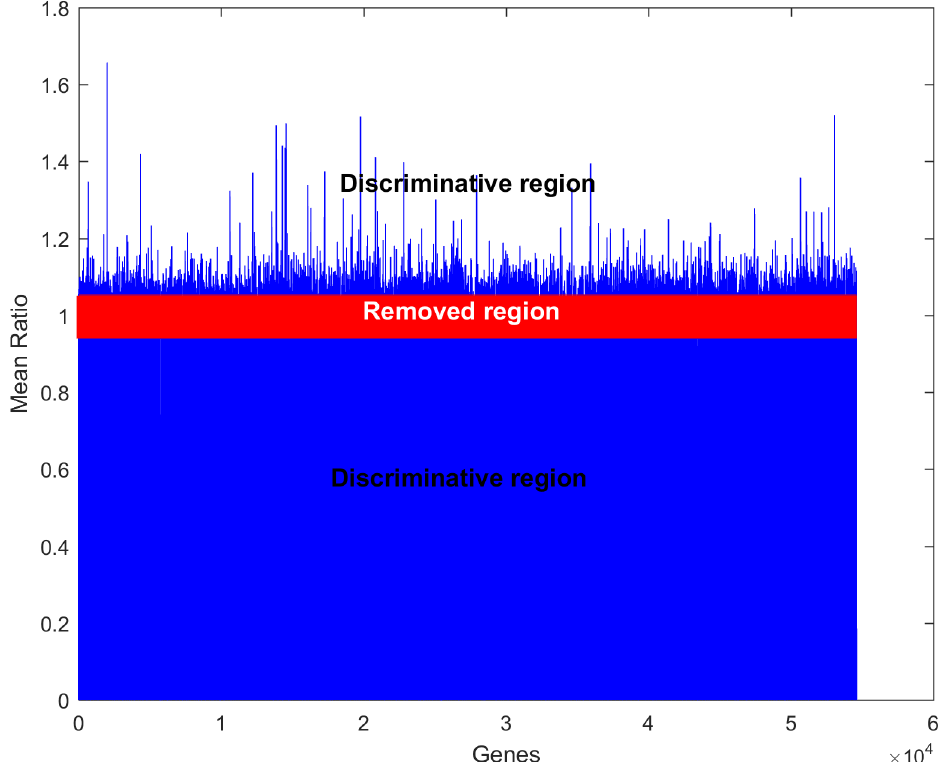
https://doi.org/10.1371/journal.pone.0187371.g007